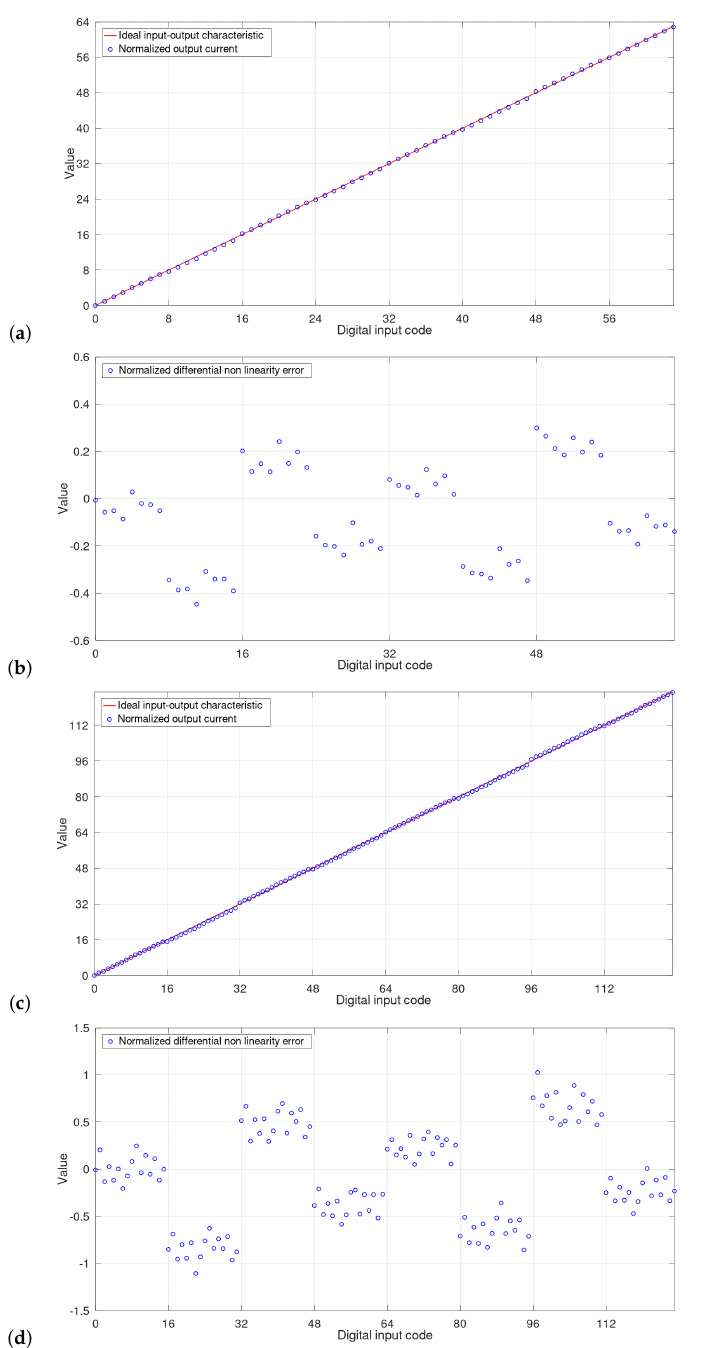
Figure 5. Selected measurement results of the prototype current-mode digital-to-analog converter (DAC) implemented in the CMOS 130 nm technology: ( a ) Input-output characteristic for the resolution of 6 bits; ( b ) Normalized differential non linearity error for the resolution of 6 bits; ( c ) Input-output characteristic for the resolution of 7 bits; ( d ) Normalized differential non linearity error for the resolution of 7